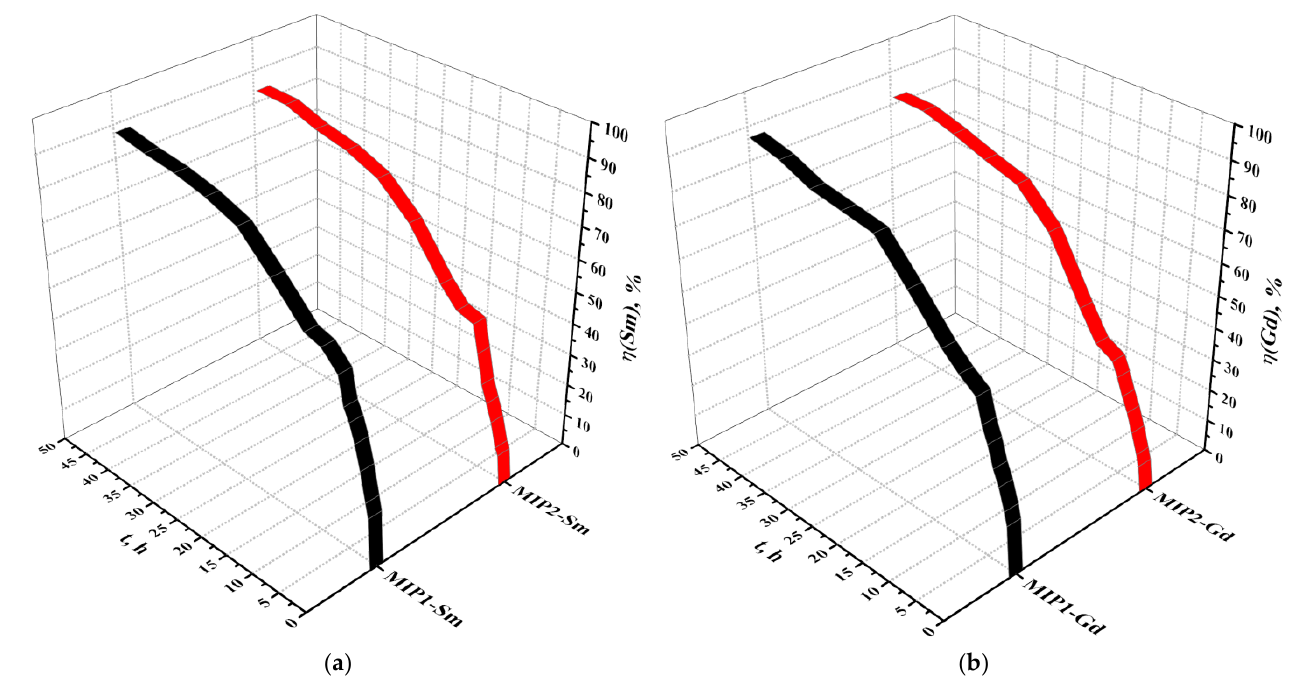
Figure 5. Extraction degrees of samarium ( a ) and gadolinium ( b ) during sorption via molecularly imprinted polymers. Table 2. Values of extraction degrees of samarium and